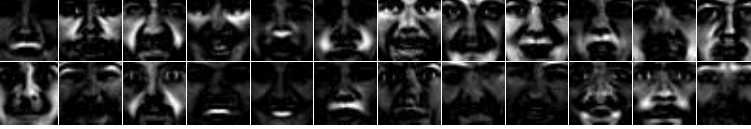
Figure 10. Features achieved by NMF for MUG